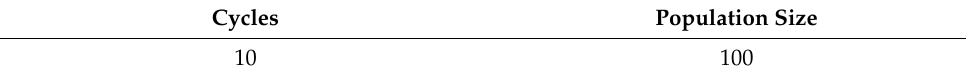
Table 3. Parameters of the GA for case 1. Cycles